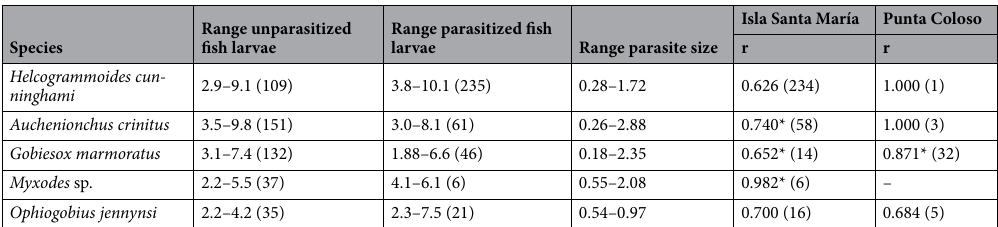
Table 2. Body length ranges of unparasitized and parasitized fish larvae species, parasitized body size and correlation coefficients between parasitized fish larvae length and ectoparasite length per each area (Isla Santa María and Punta Coloso). *Significant at P < 0.05.